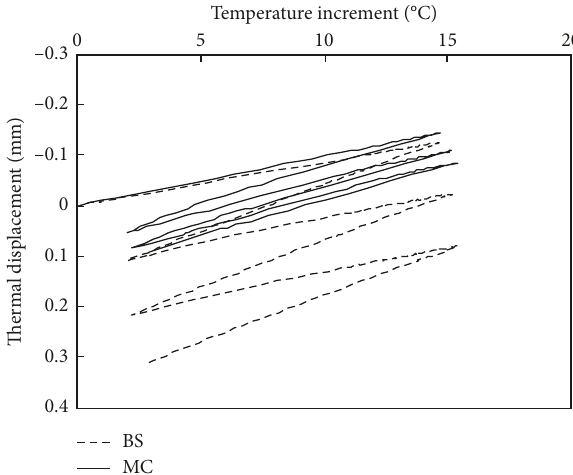
Figure 8: Predicted thermal displacement under the ultimate load.